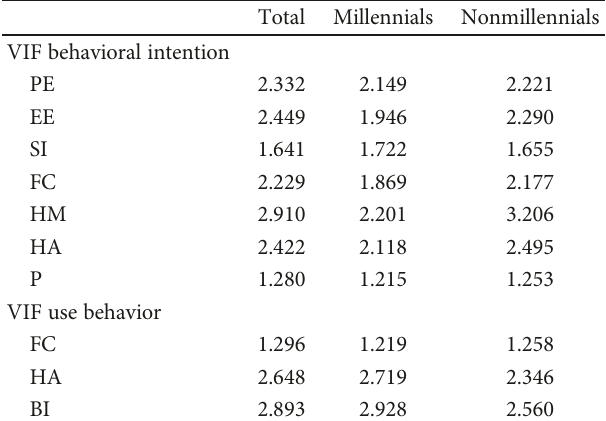
Table 4: Full collinearity